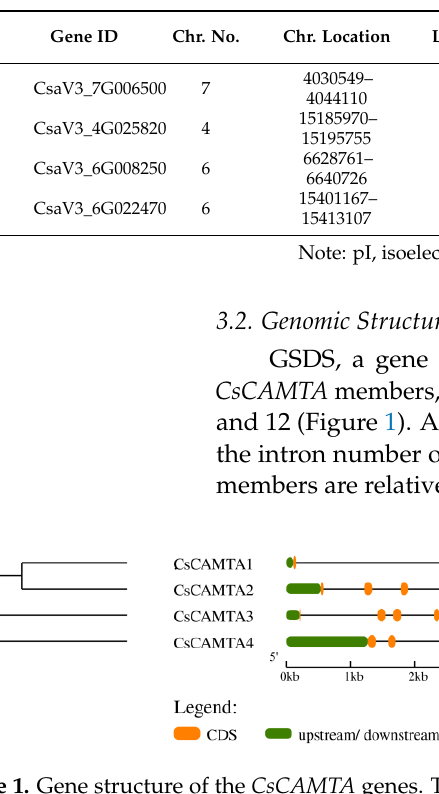
Figure 1. Gene structure of the CsCAMTA genes. The untranslated regions (UTRs) are indicated by thick green boxes; the exons are indicated by thick orange boxes; the introns are indicated by black lines.